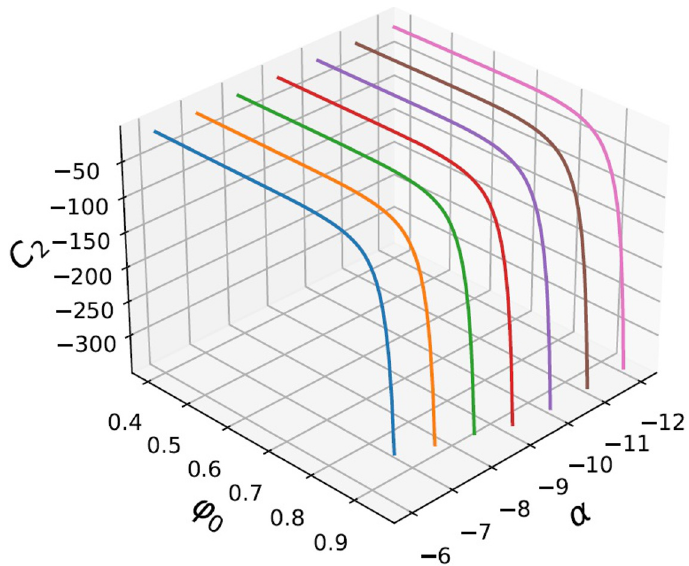
Figure 20 . The integration constant C 2 as a function of the two parameters, ϕ 0 and α , for Bolt end-point solutions.